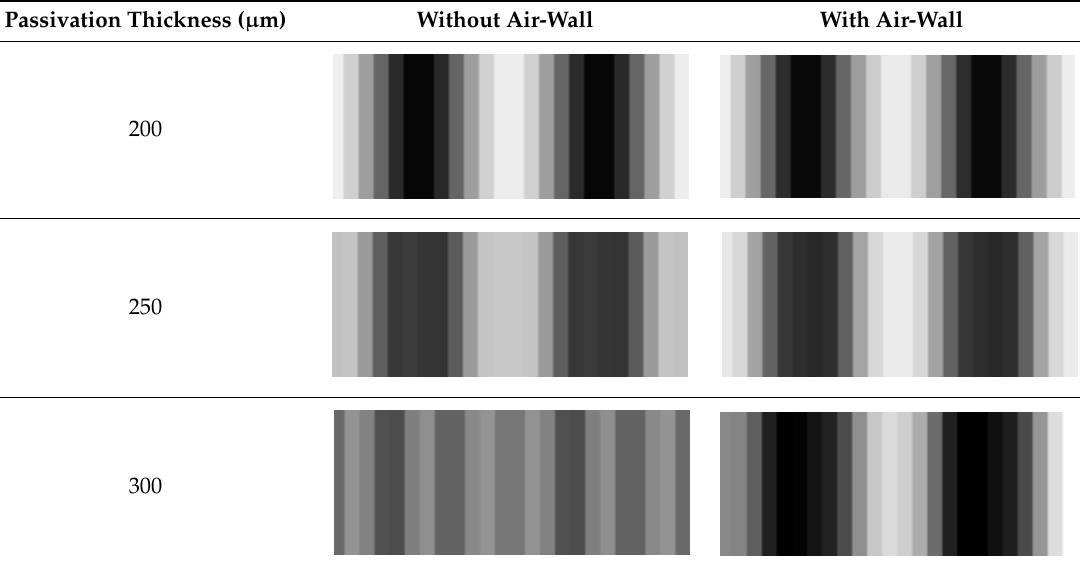
Figure 7. Performance index Δ C norm vs. thickness of the passivation layer, for the systems with and without an air-wall: ( a ) Fingerprint pattern frequency of 2.5 lp/mm; ( b ) Fingerprint pattern frequency of 1.67 lp/mm. Table 2. Image quality comparison, for the systems with and without an air-wall, for the spatial frequency of 2.5 lp/mm.